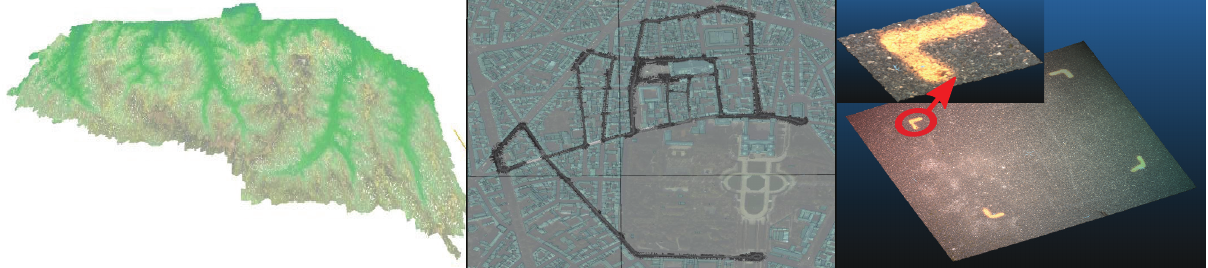
Figure 6: Vosges dataset (aerial Lidar), Paris dataset (terrestrial Lidar), Stereo dataset (Stereovision)